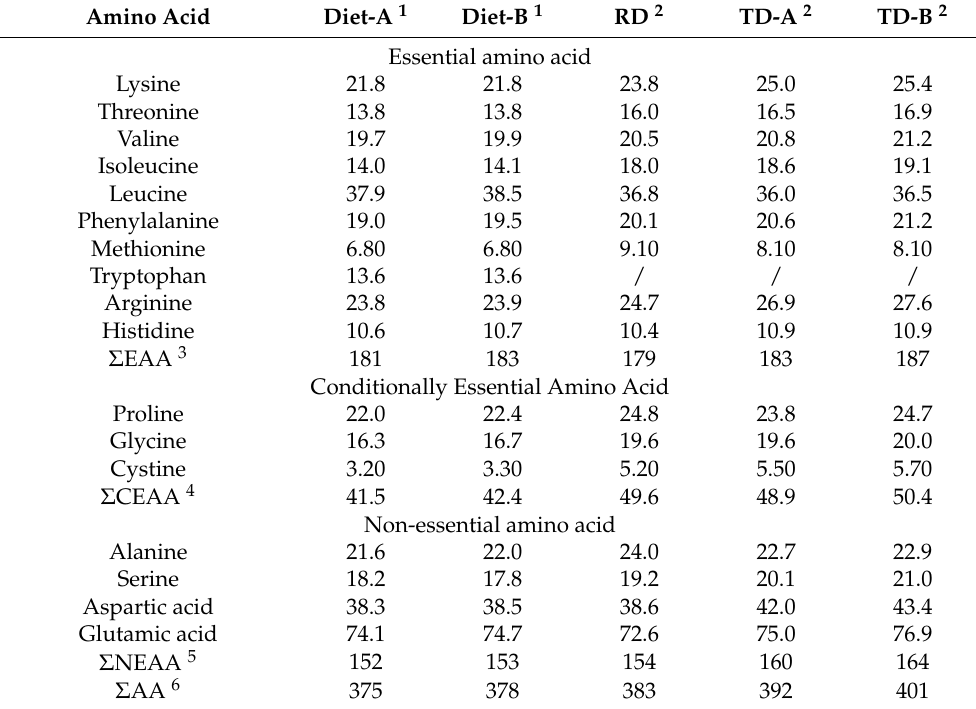
Table 2. Amino acid profiles of tested diets in growth and digestibility trails (g/kg, as is basis). Amino